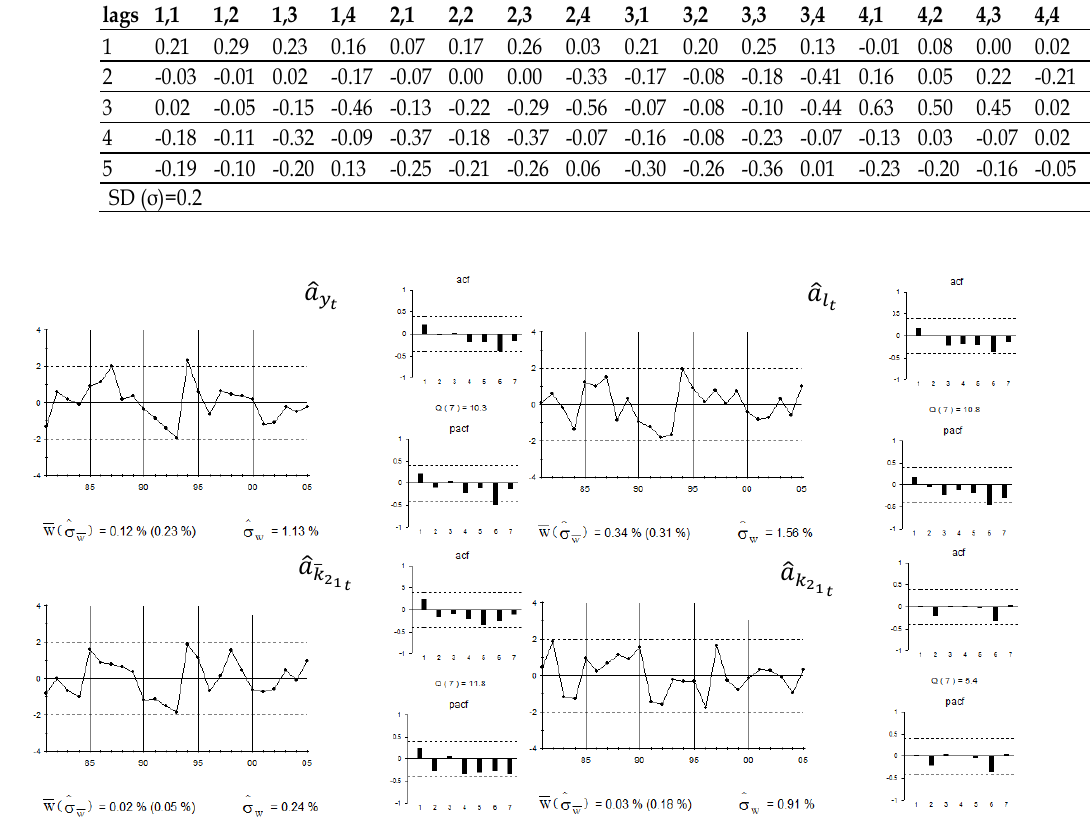
Figure 1. Residual series and their Autocorrelation (ACF) and Partial Autocorrelation (PACF)